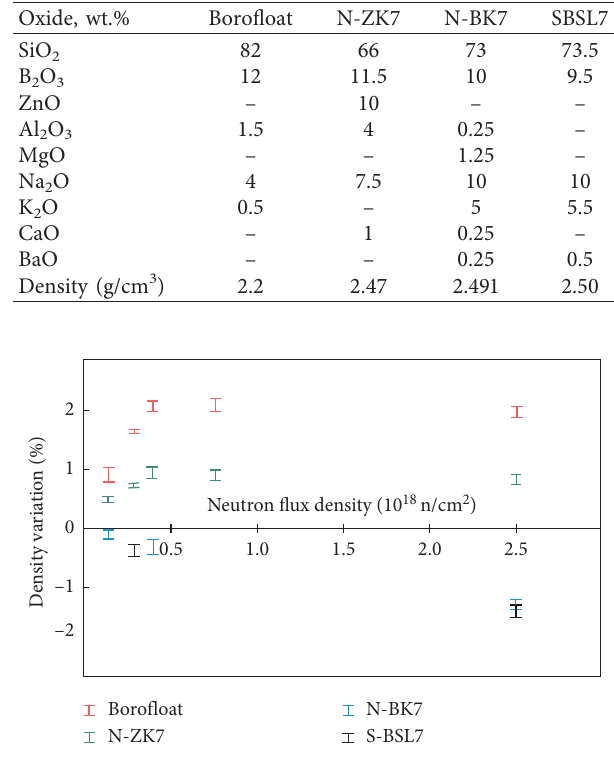
Figure 6: Dynamics of density changes in borosilicate glasses during bombardment by a neutron flux according to Boffy et al. [43]. The neutron flux is 2 × 10 13 n /(cm 2 · s). The glass compositions are shown in Table